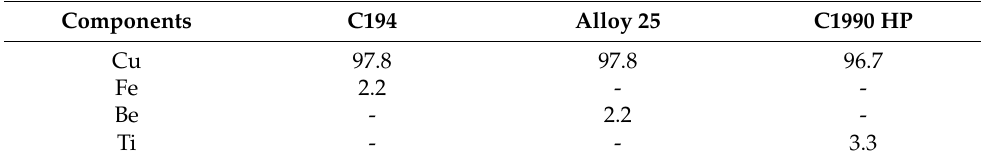
Table 1. Chemical composition of C194, Alloy 25, and C1990 HP (in wt.%) substrates.